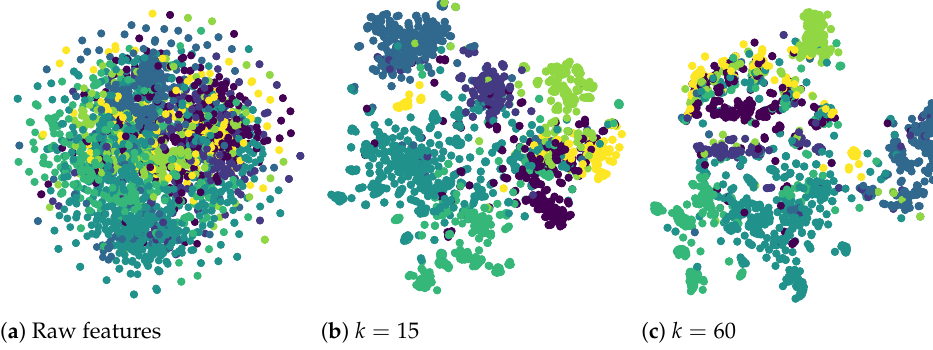
Figure 1. t-SNE demonstration of the raw and filtered node features of Cora dataset.